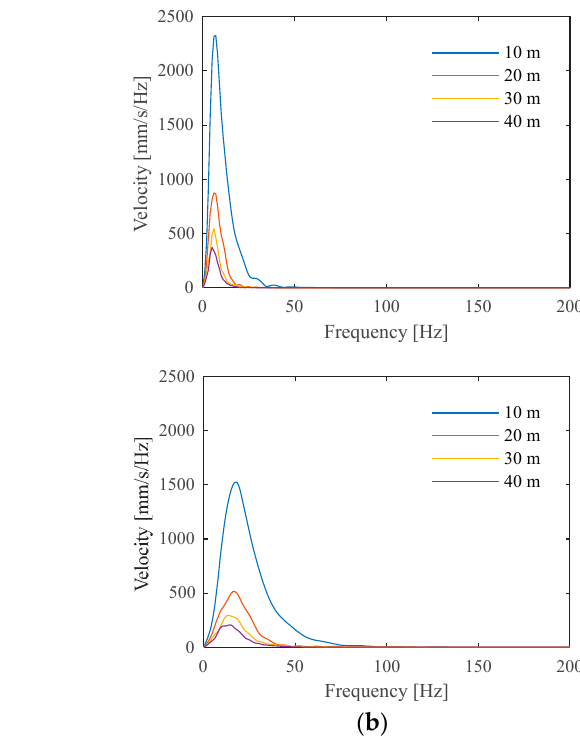
Figure 10. PPV versus distance from the pile due to impact pile driving for different ground stiff- nesses: ( a ) linear analysis; ( b ) equivalent linear analysis.